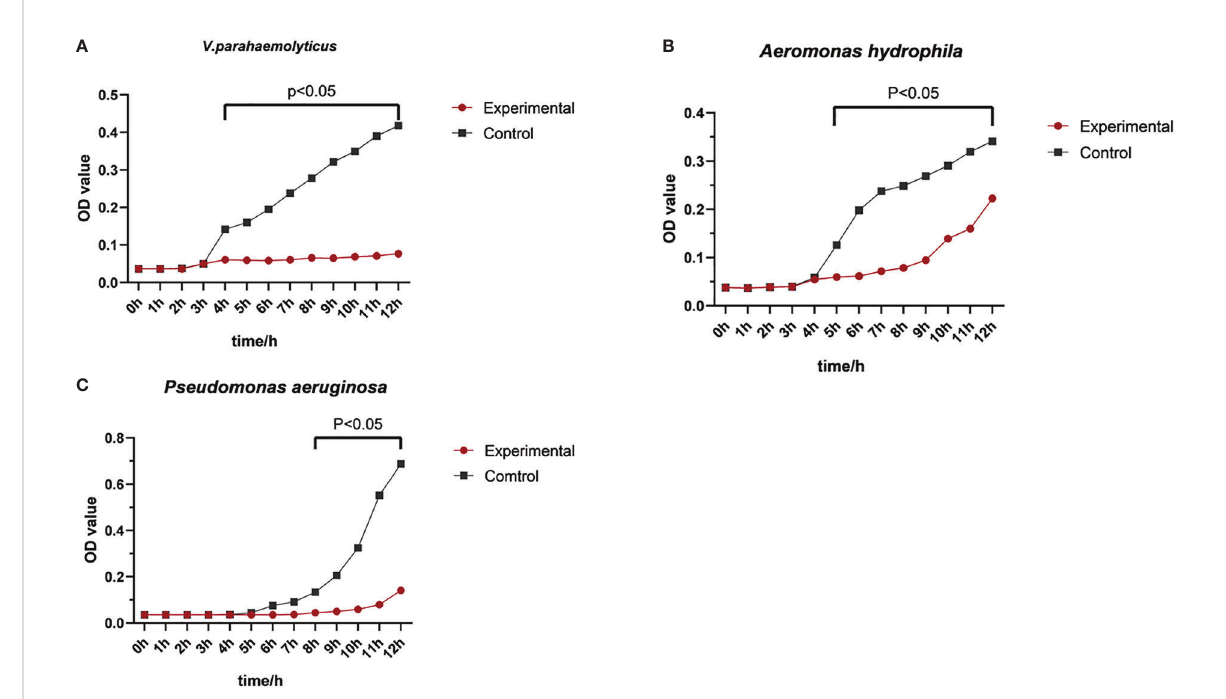
FIGURE 7 Antibacterial activity of rPmlysG. Control group: PBS. Experimental groups; (A) V. parahaemolyticus challenge; (B) A hydrophila challenge; (C) Pseudomonas aeruginosa